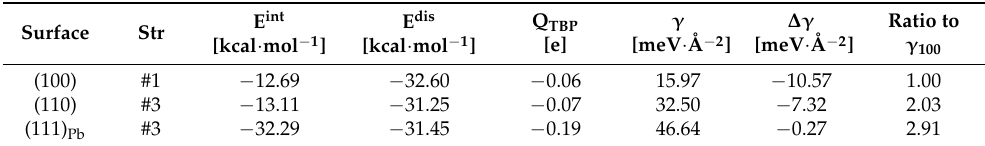
Table 4. Interaction energy (E int ), distortion energy (E dis ), Bader’s charge in TBP, surface energy ( γ ), surface energy shift relative to unmodified surface ( Δγ ) and ratio for the low-lying states of (100), (110) and (111) Pb surface models interacting with the TBP molecule.